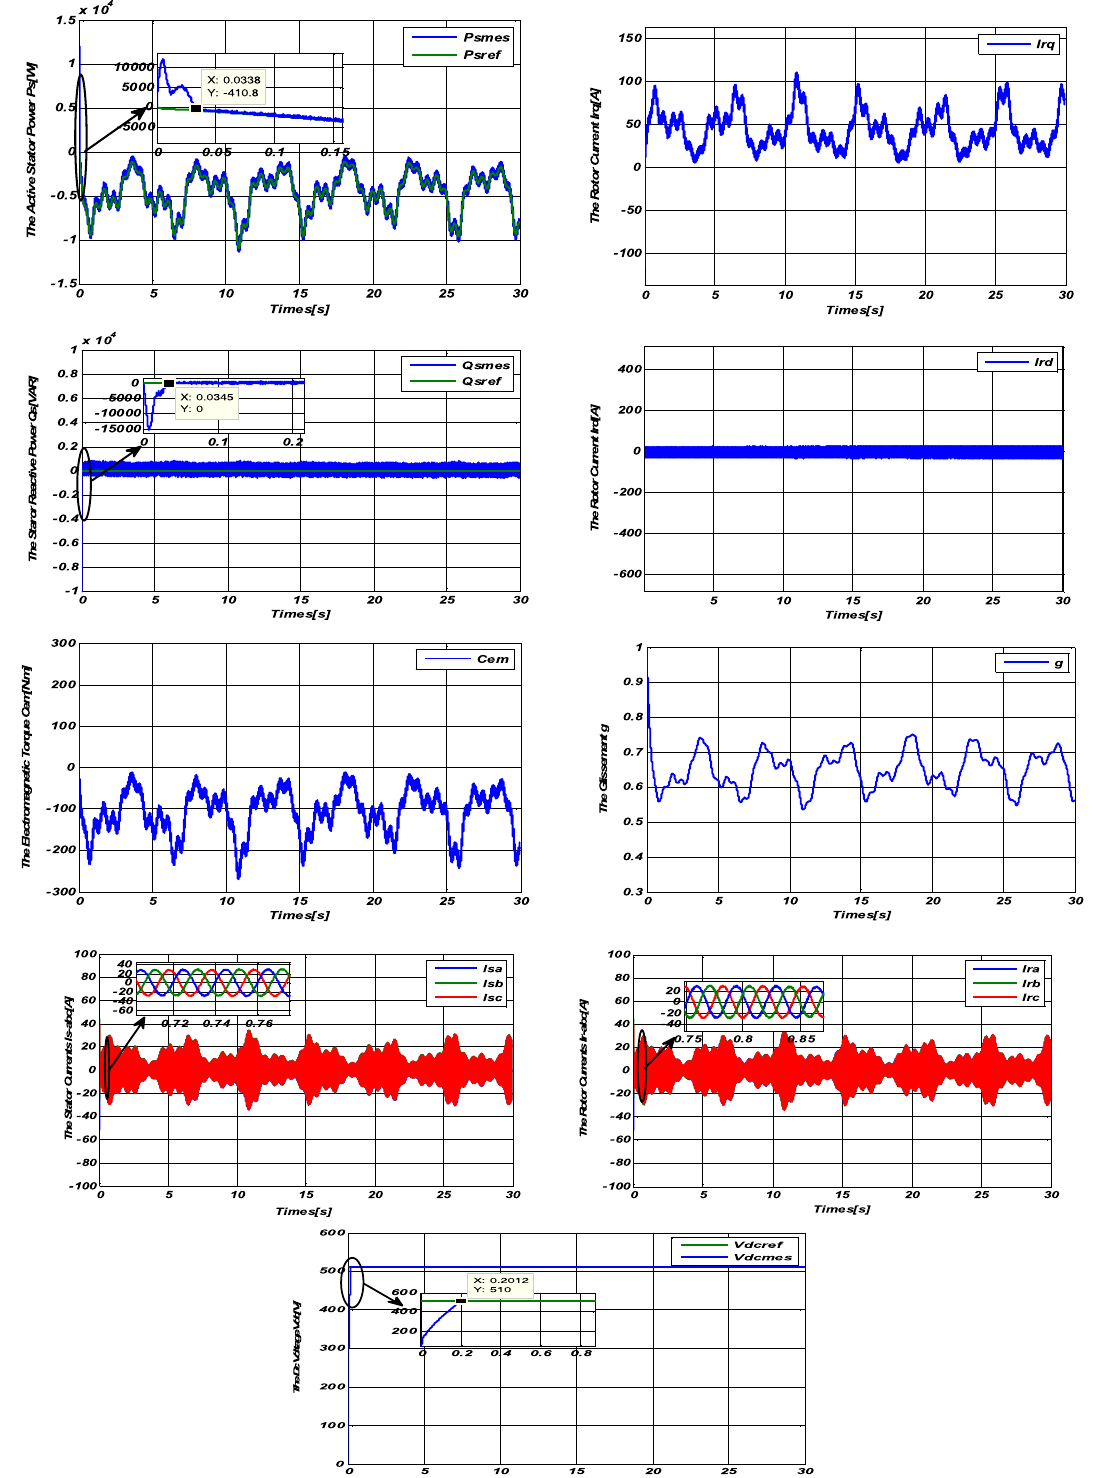
Figure 6. Results of the Sliding-Backstepping Mode variable speed